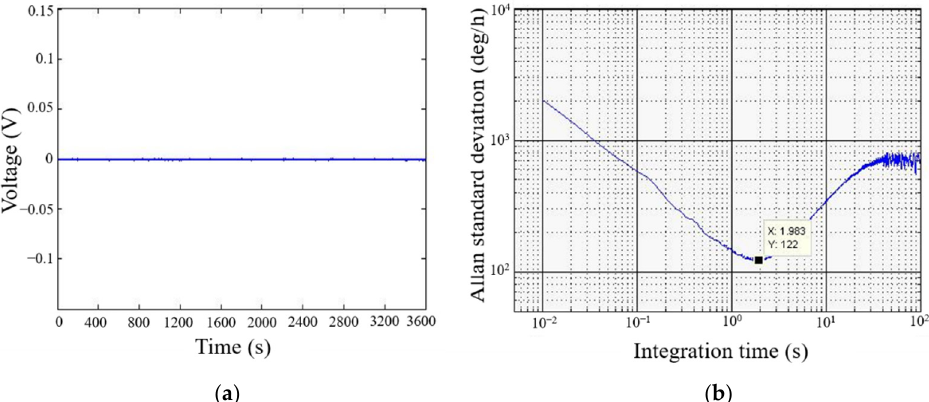
Figure 6. ( a ) One-hour static test result; ( b ) Allan standard deviation of the rotation data ( g 1 = 6.9 μ m and g 2 = 6.7 μ m).